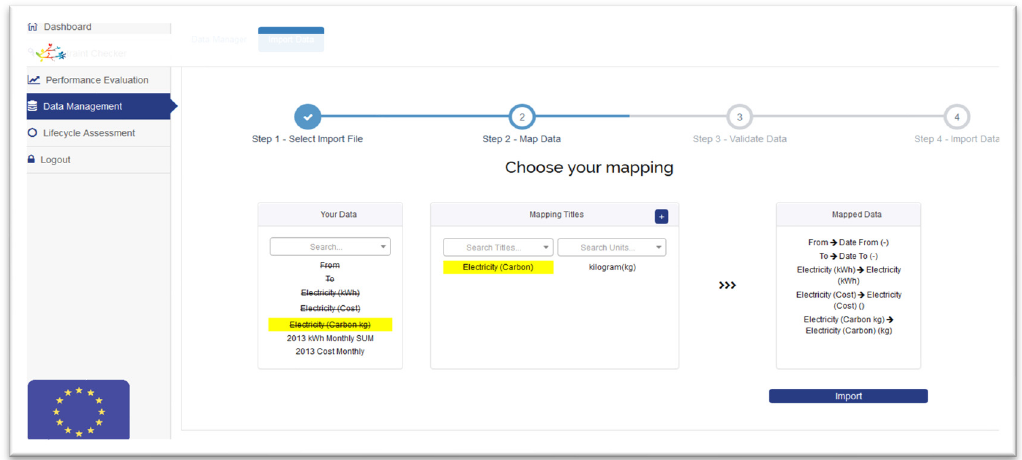
Figure 5. BIMcpd Data Management Tool—data